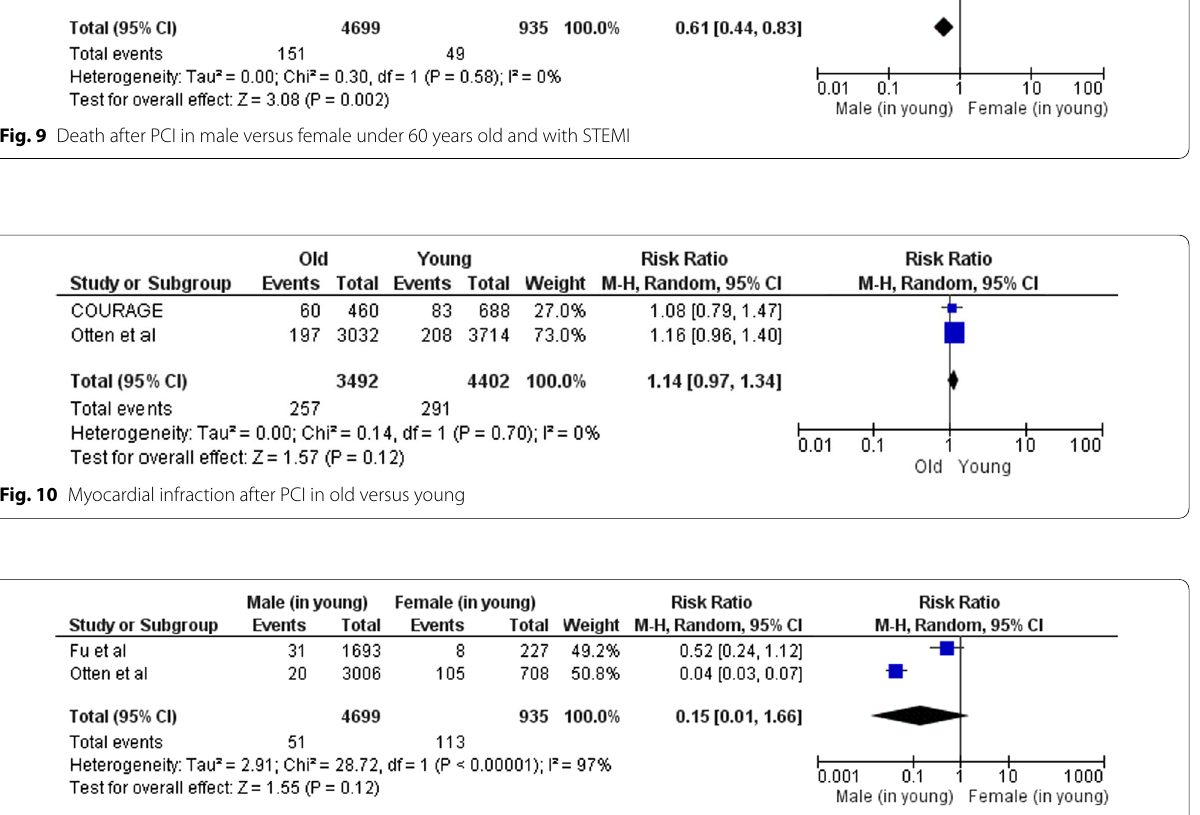
Fig. 11 Myocardial infraction after PCI in male versus female under 60 years old and with